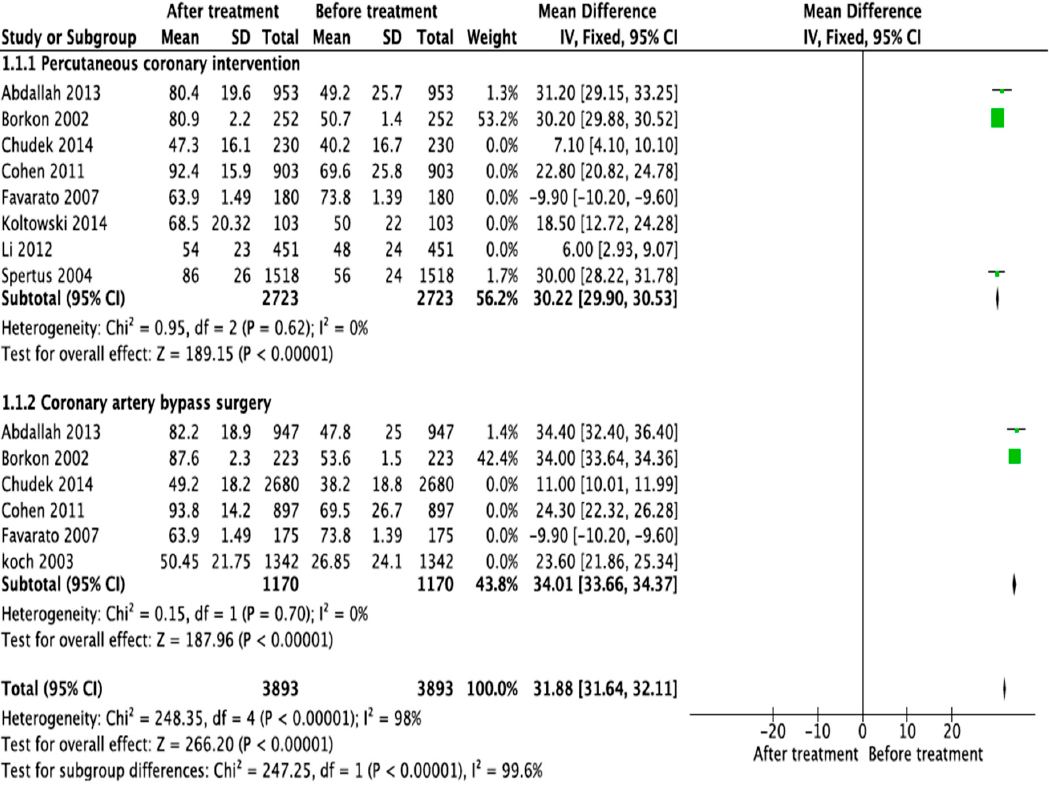
Figure 2. Forest plot of meta ‐ analytic association between QoL and ACS treatments, 2019.